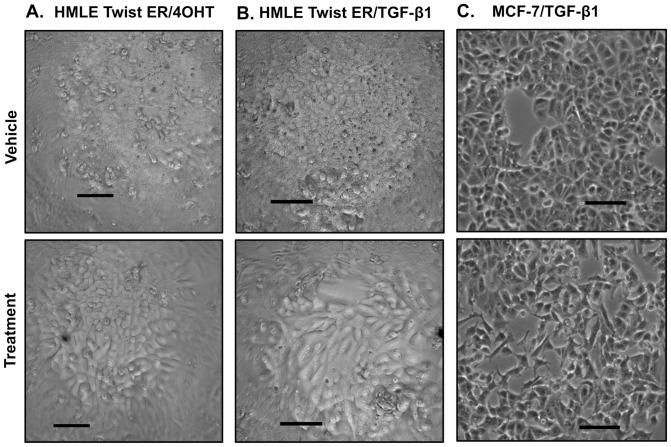
Representative morphology of cells under array conditions following 4 days of treatment.
Top panel: vehicle control; bottom panel: cells treated with EMT inducers. HMLE Twist ER cells in 384- well plates used for arrays lost the ability to form a dense epithelial sheet, consistent with the loss of adherens junctions and other epithelial structures observed in EMT. Cells were also elongated and spindle-shaped compared to untreated controls. MCF-7 cells treated with TGF-β1 also lost the ability to pack together in the cobblestone-like formations typical of this cell line. Treated cells also lost their uniform hexagonal shape and became elongated with pleiomorphic cellular processes. A. HMLE Twist ER cells treated with vehicle or 4OHT. B. HMLE Twist ER cells treated with vehicle or TGF-β1. C. MCF-7 cells treated with vehicle or TFG-β1. Scale bar, 100 μm.